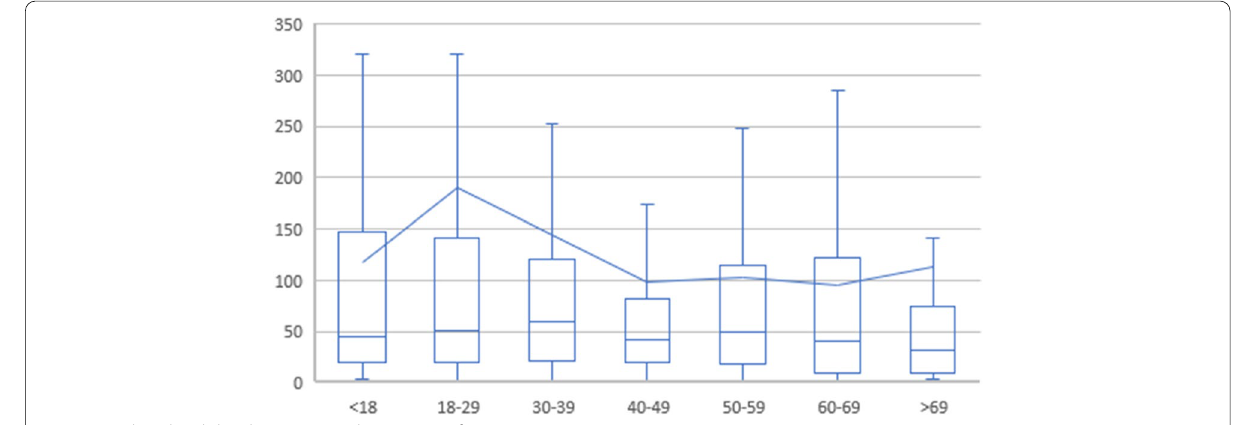
Fig. 2 Total IgE level distribution according to age of participants